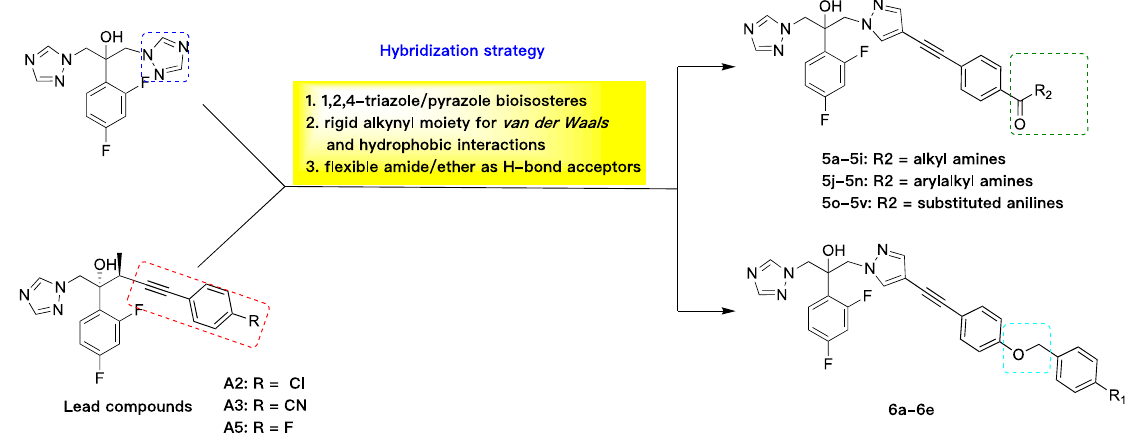
Figure 2. Design strategy of target compounds.